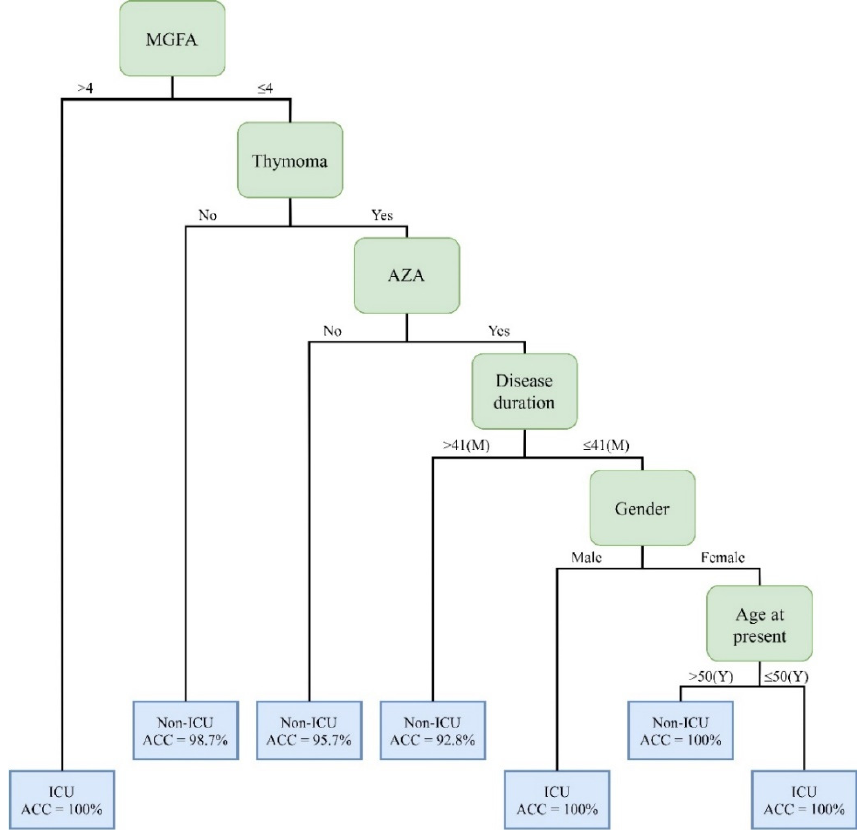
Figure 5. Decision rules for the prediction of ICU admission in MG patients based on important